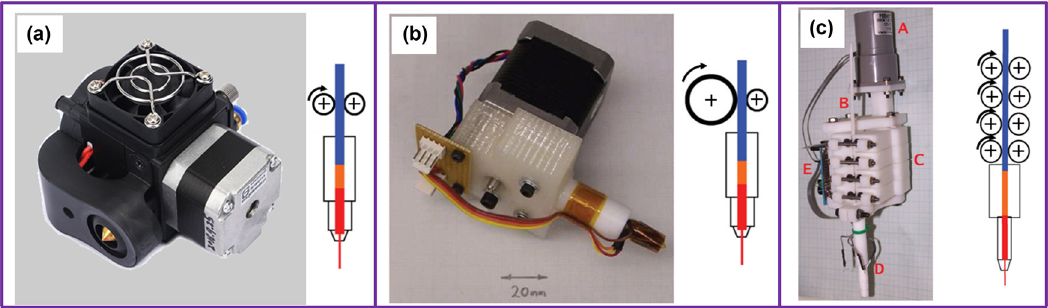
Figure 4: Gear - driven extrusion - based nozzles for FDM printers: ( a ) drive gear having same diameter size as bearing roller; ( b ) drive gear having larger diameter size than bearing roller; ( c ) multiple drive gears and bearing rollers but drive gears having same diameter size as bearing rollers. Adopted from ref. [ 76 ] with modi fi cation.